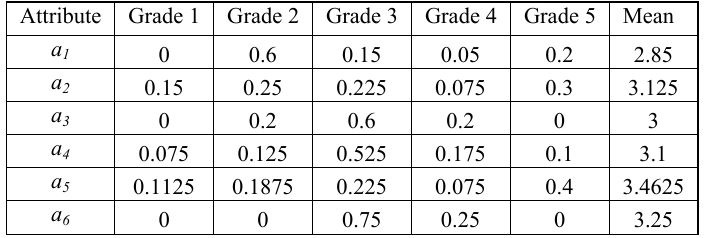
Table 7 Assessments on the desired scale using quadratic mapping function with t =2